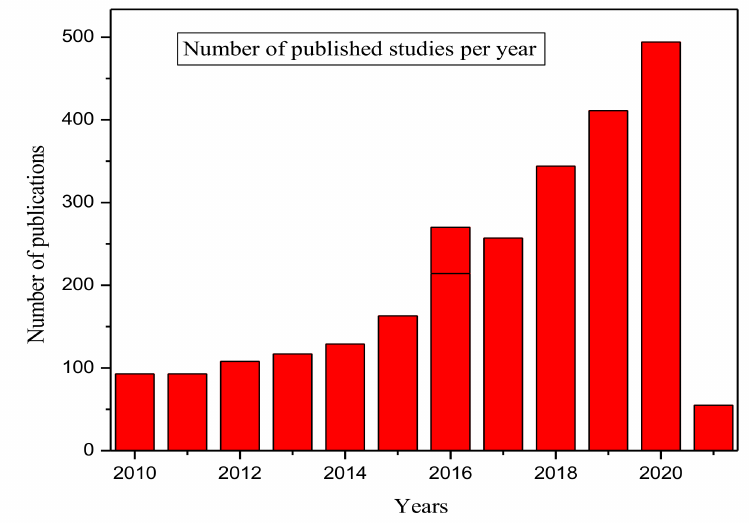
Figure 7. Heavy metal contamination in food and the number of outputs per year. Data analysis was completed using the Web of Science database on 04 March 2021 by the